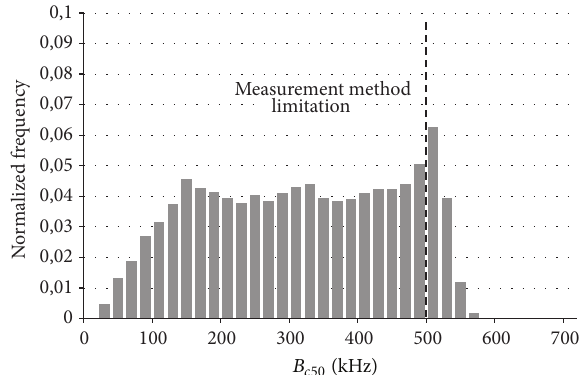
Figure9:Histogramofcoherencebandwidthvaluesestimatedfrom rms delay spread for correlation level 0.5 in the Gdansk city area.